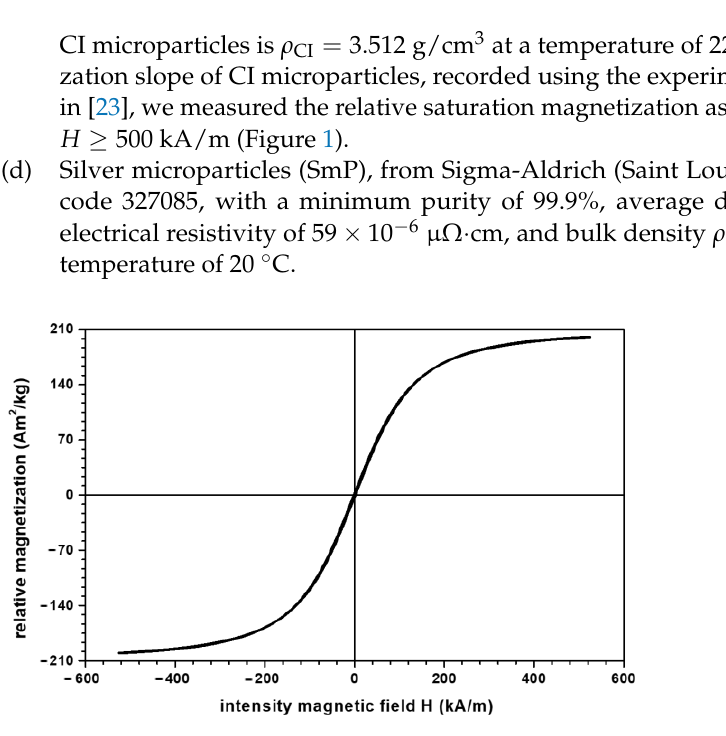
Table 1. Liquid magnetic